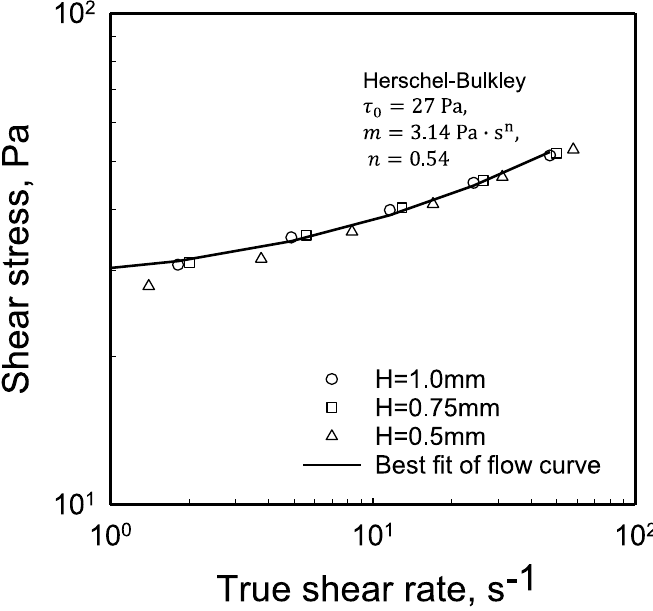
( ) τ Figure 13. Shear stress at the edge, | τ z θ ( R ) | , versus the true (slip corrected) shear rate at the edge, R θ Figure 13. Shear stress at the edge, , versus the true (slip corrected) shear rate at the edge, z dV θ ( R ) = . γ ( R ) , from the data collected at three gaps, H . The parameters of the Herschel–Bulkley dr dV ( ) θ γ=  , from the data collected at three gaps, H . The parameters of the Herschel– ( ) R R Equation of the hydrogel are yield stress, τ 0 = 27 Pa, m = 3.14 Pa-s n and n = 0.54. dr τ Bulkley Equation of the hydrogel are yield stress, 0 = 27 Pa, m = 3.14 Pa-s n and n = 0.54.